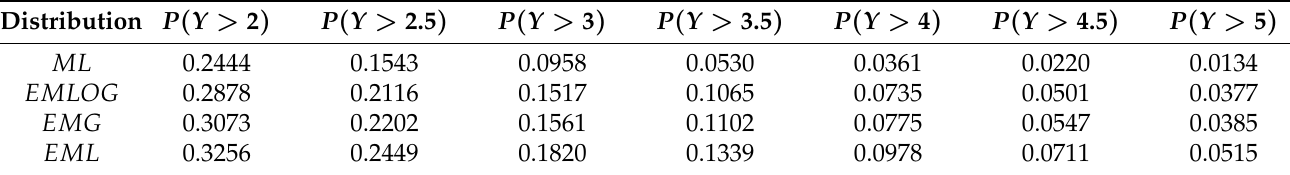
Table 1. Reliability function comparison for distributions ML , EMLOG , EMG , and EML